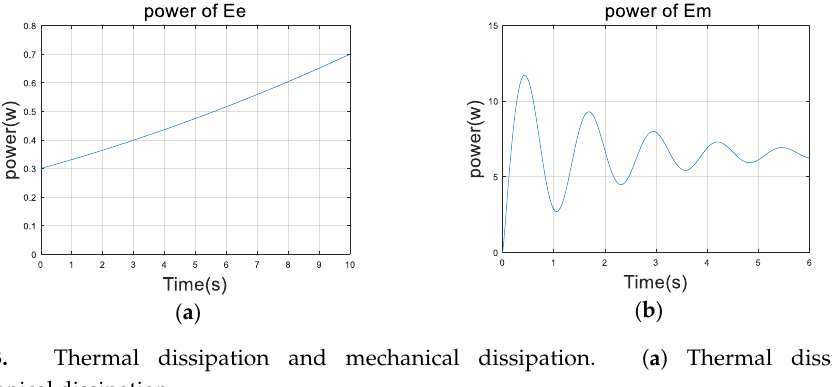
Figure 3. Thermal dissipation and mechanical dissipation. ( a ) Thermal dissipation; ( b ) Mechanical dissipation.